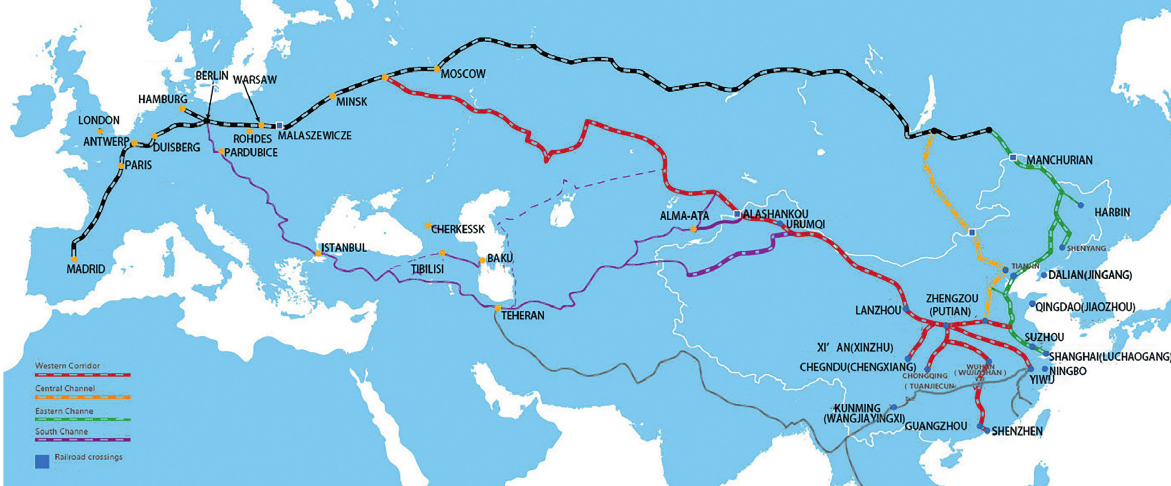
Figure 1: Route map of CR Express. It shows the three lines of CR Express by colouring as red, yellow, and green, respectively, which correspond to the direction of west, middle, and east.